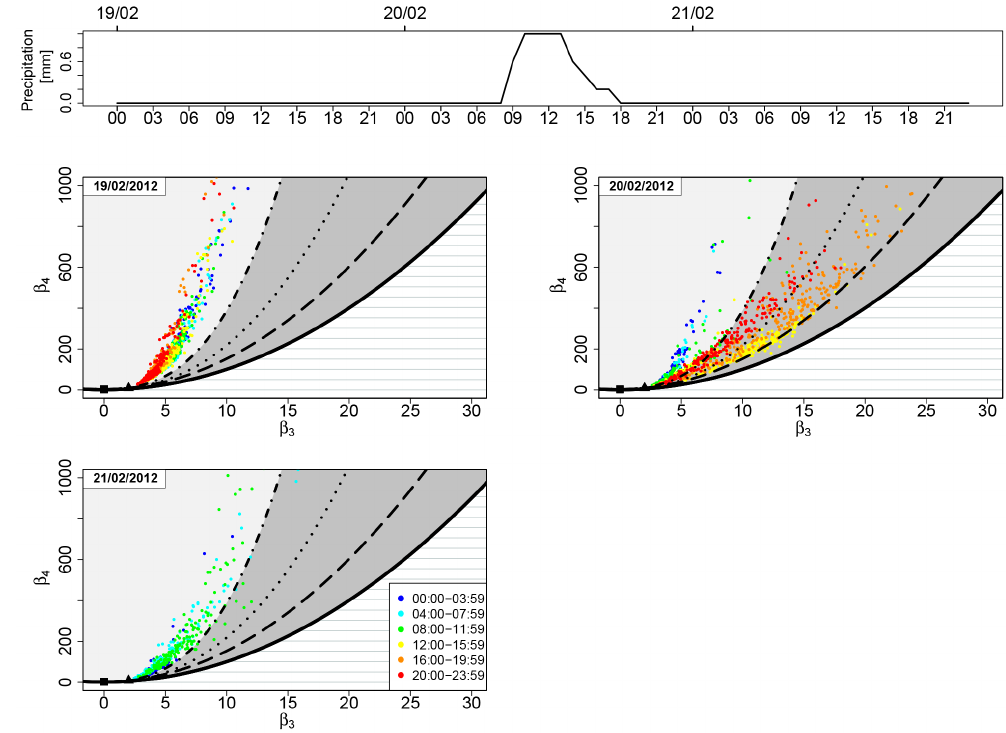
Figure 6. Location of the sample couples ( β 3 , β 4 ) in the skewness–kurtosis plane for the days 19, 20 and 21 February 2012. The dots are coloured according to the time slot as explained in the legend. Between 09:00 and 17:00UTC of 20 February a precipitation event with a maximum intensity of 1mmh − 1 and average intensity of 0.6mmh − 1 occurred.